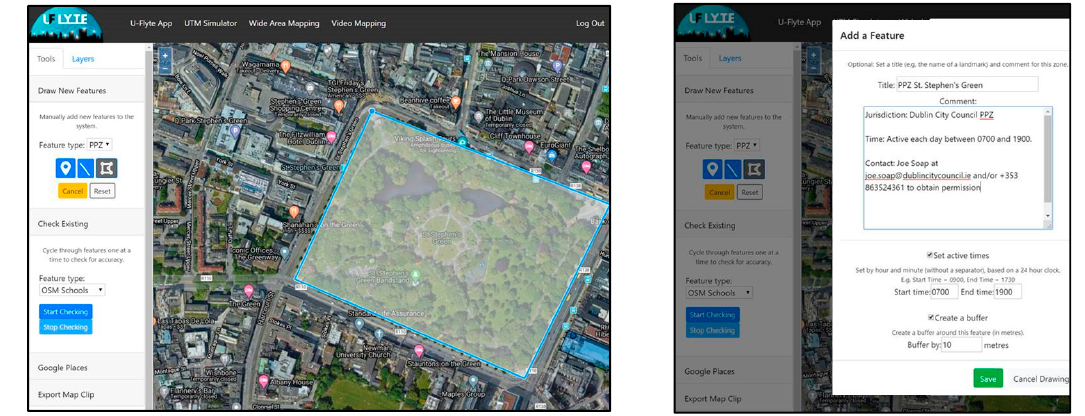
Figure 9. U-Flyte’s UTM platform Mark-up tool to enable collaborative urban airspace construction.